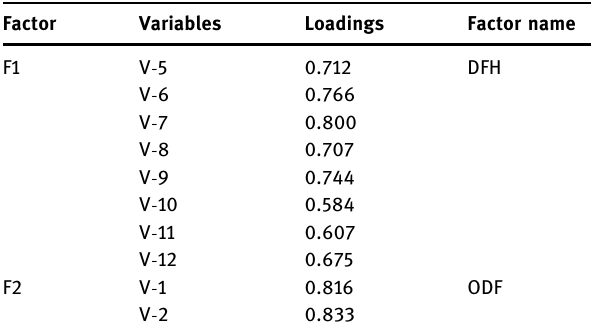
Table 5: Final FA solution with extraction by PCA and Varimax rotation Factor